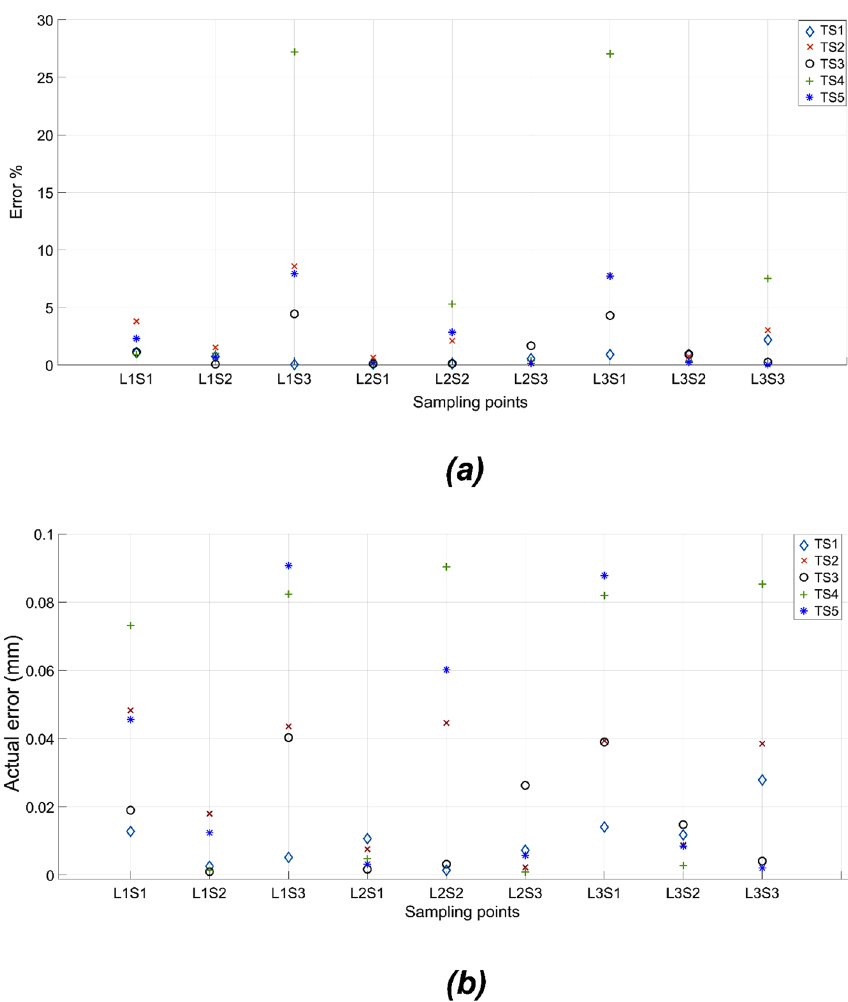
Figure 12. The mean of the difference between the deflection in nine sampling points and the corresponding target deflections for TS1 to TS5 in 20 voxel symmetric single void models is expressed as ( a ) percentage and ( b ) actual difference in deflections. Each data point corresponds to the mean value of 5 independent trials.